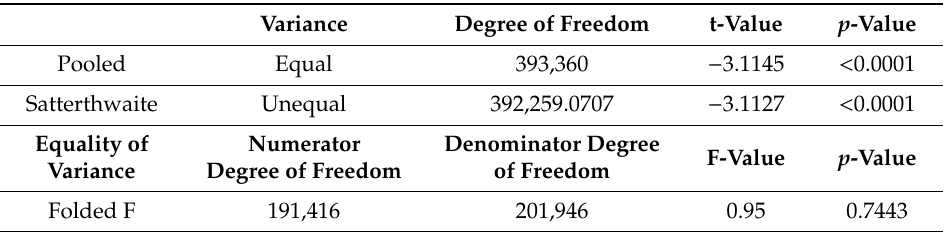
Table 15. Two-sample t -test for H3c.